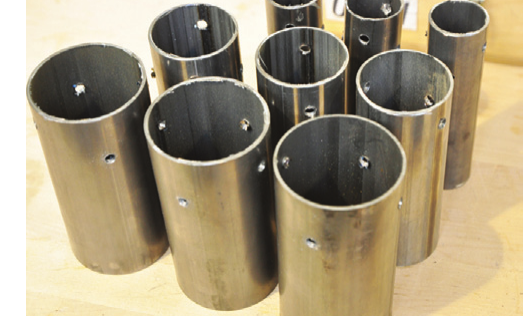
Fig. 1. CHS connectors prepared for a test setup